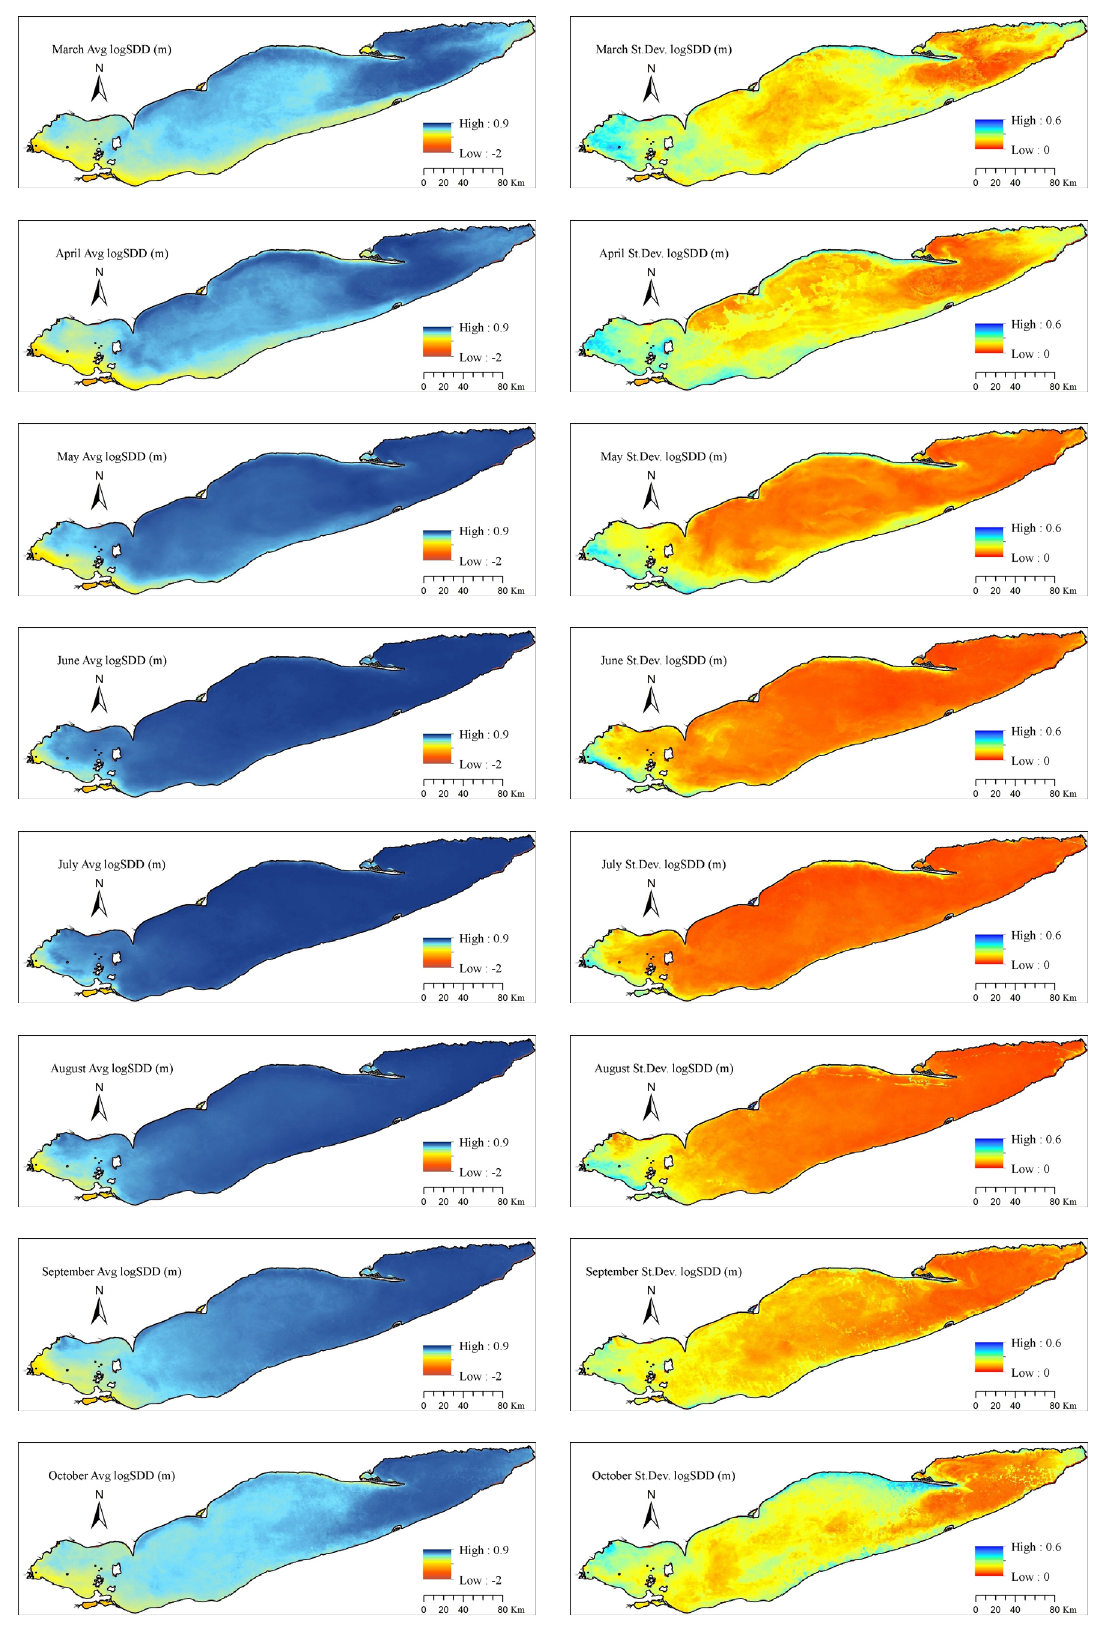
Figure 8. SDD average (Avg, ( a )) and standard deviation (St. Dev., ( b )) in log 10 scale from March to October for the study period (2005–2011). The number of available pixels for each month is shown in Figure